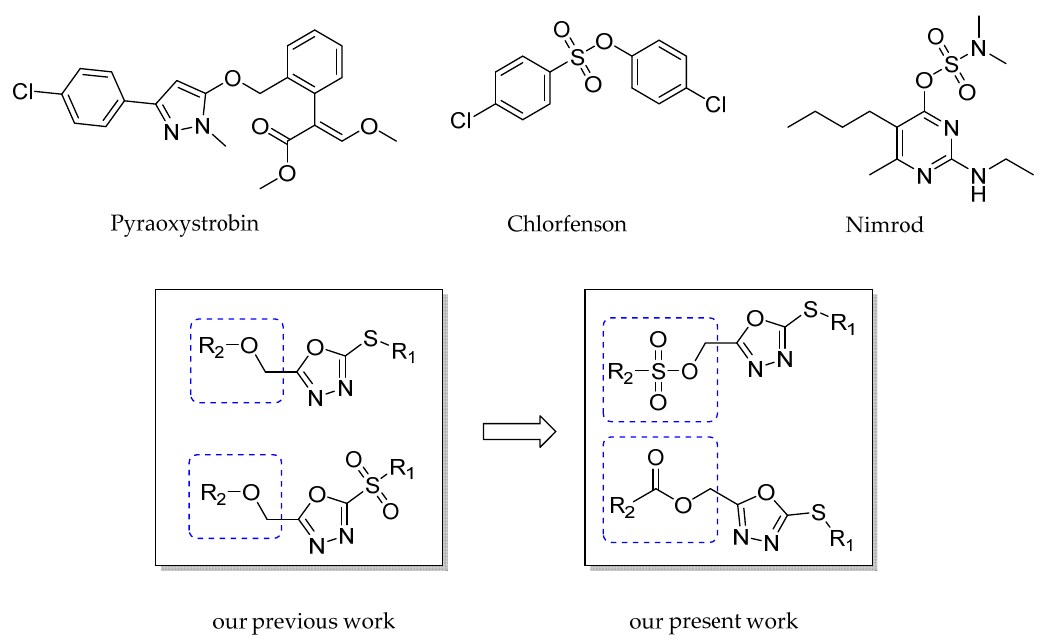
Figure 1. Design of the target compounds.